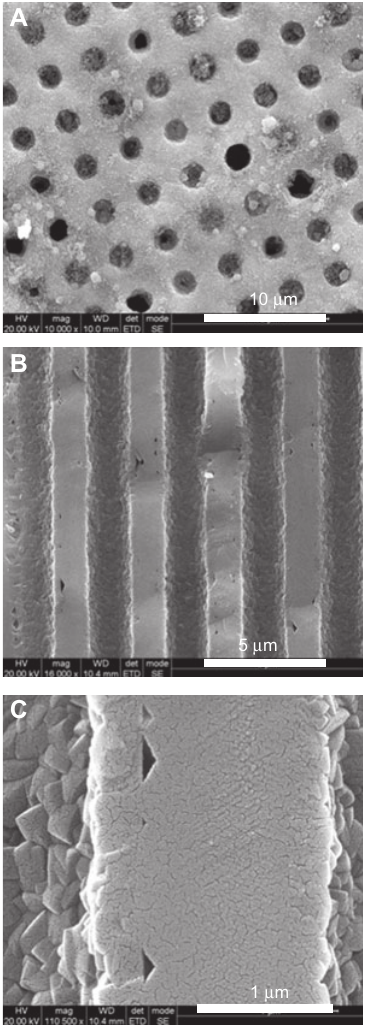
Figure 5 SEM images of microwave synthesis of ZSM-5 on silicon micromonoliths.